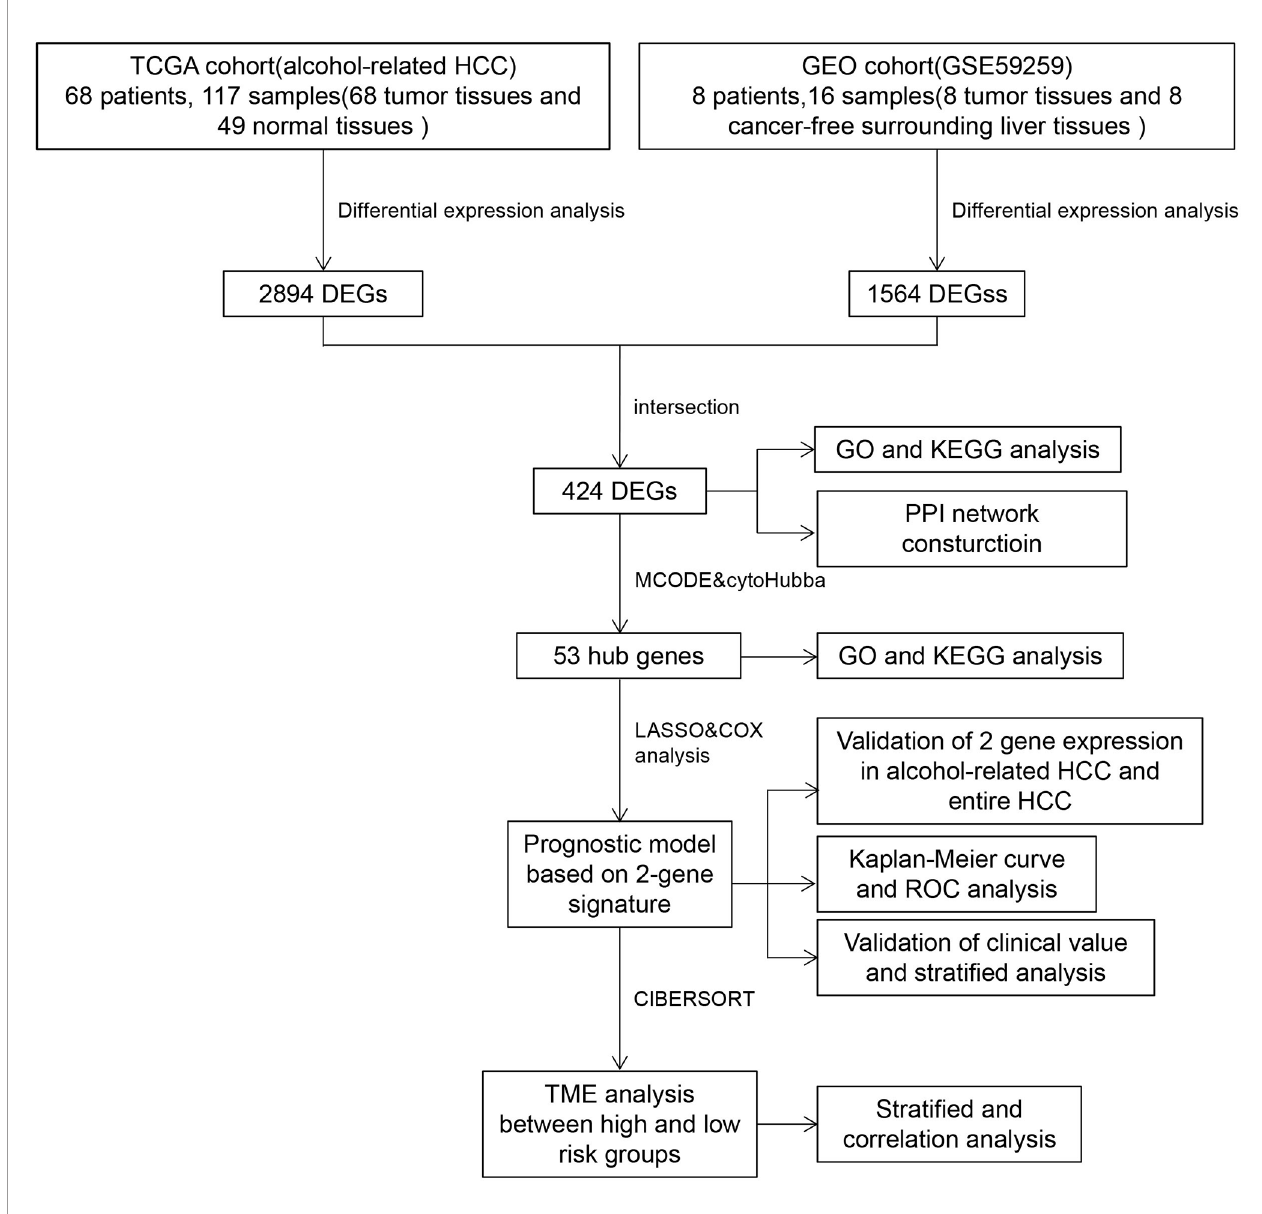
FIGURE 1 | Overall fl owchart of the study.